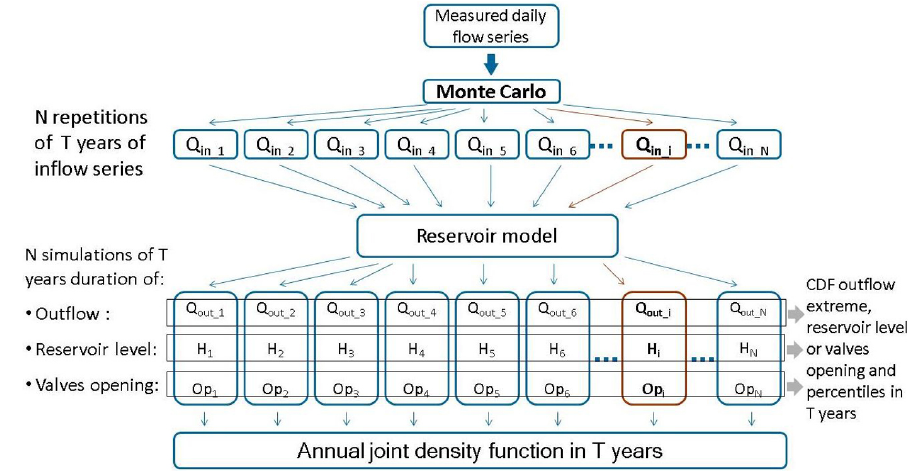
Fig. 3. Scheme of the procedure followed to derive probability functions for the variables